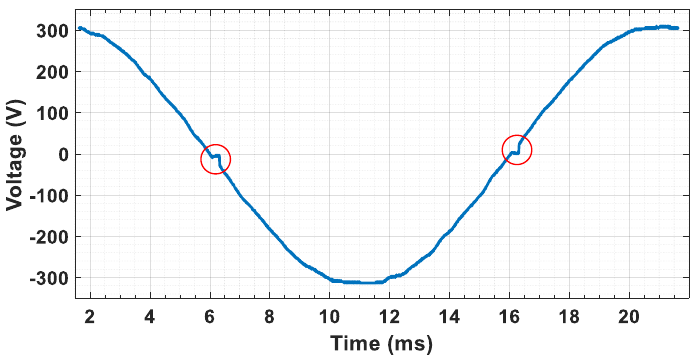
Figure 9. An example of practical conduction delay at zero voltage crossing for ohmic load with pulse strategy.